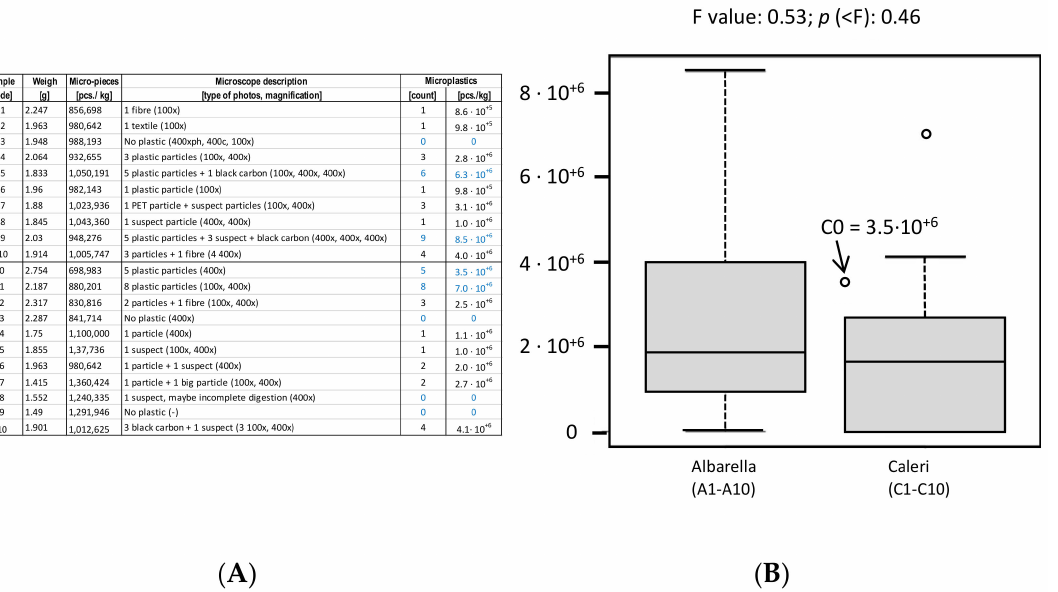
Figure 9. Microplastic content (pieces per kg; pcs./kg) in the soil samples of Albarella and Caleri. Table on the left ( A ) and boxplot on the right ( B ): median, first quartile in the boxes, second quartile within the whiskers, and extreme values. Numbers in Blue are comparabily safe, single count can be questioned, all low numbers are not very accurate. C0 = first 5 cm of soil under 50 cm of water, low tide; collection made in Caleri, at a point 50 m from